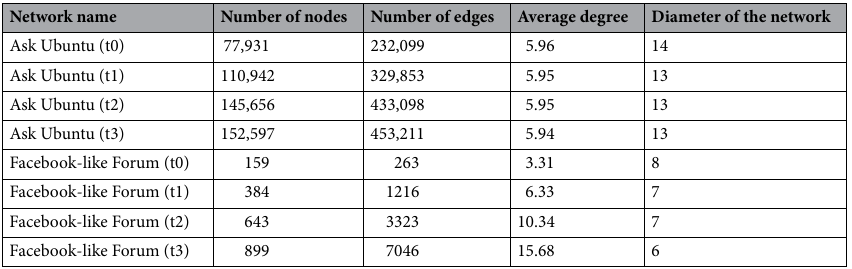
Table 1. Basic information of the typical social